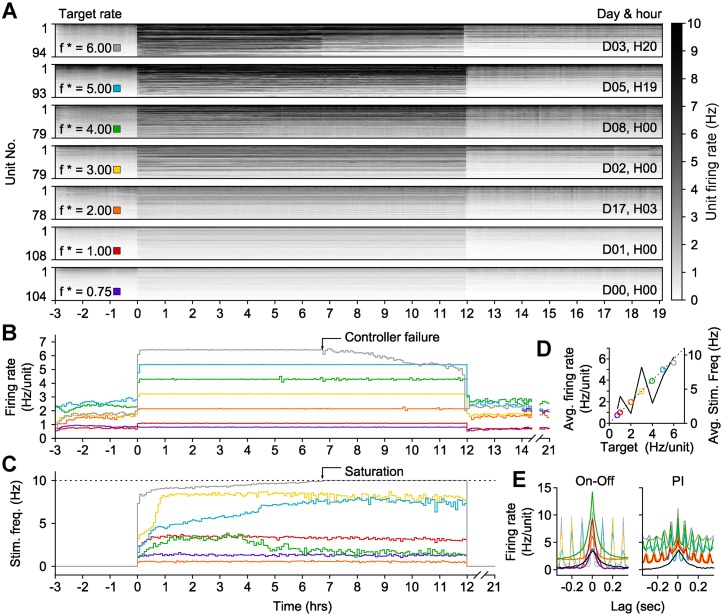
On-off feedback control of population firing rate over 12-hr epochs.(All data presented in this figure were obtained from a single culture over the course of ∼3 weeks.) (A) Firing rates of detected units during 12-hr control periods are represented using the grey-scale to the right. At time 0, the on-off controller was engaged and the average network rate was clamped firing to the target rate indicated to the left of each chart. The day and hour of each protocol, relative to the first experiment, is shown to the right. Units are sorted by their mean firing rate during the 3-hr period prior to closed-loop control. (B) The network firing rate during each control epoch (5-min bins). The color map corresponds to the target rates shown in (A). (C) Closed-loop stimulation frequency over the course of the 12-hr clamp. For a target rate of 6 Hz/unit, the controller saturated at the maximal frequency of 10 Hz at around 7 hr into the control epoch, and target tracking failed as a result. (D) Time- and unit-averaged firing rates (colors, left axis) and control signal (black, right axis) across each 12-hr clamping period. The dotted line is identity. (E) The average cross-correlation function between 30 randomly selected units during on-off or PI control are plotted for each target rate. The correlation function for spontaneous activity is shown in black. When low stimulation frequencies were required, the unimodal correlation structure of spontaneous activity was preserved using on-off control.